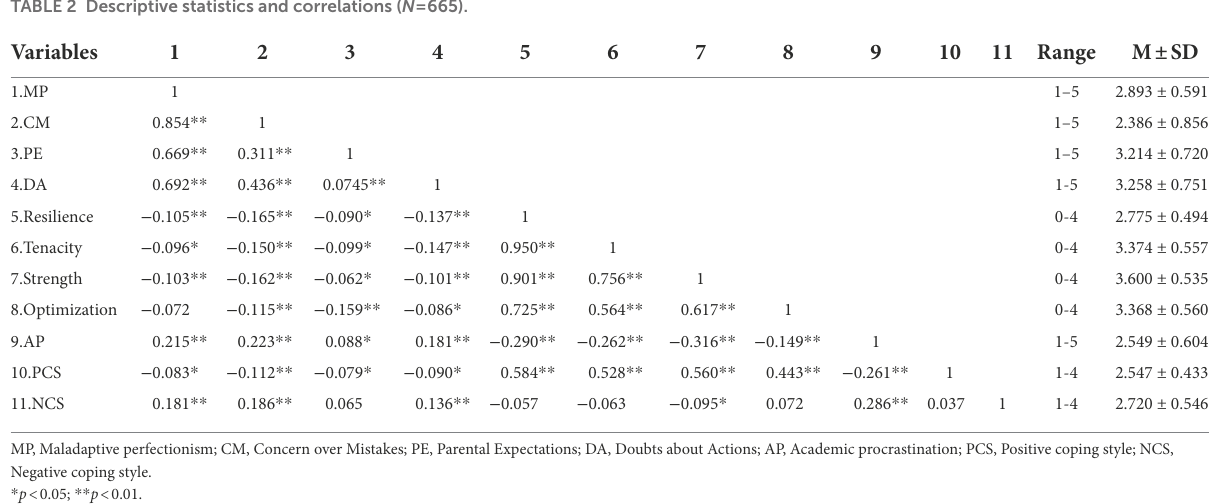
TABLE 2 Descriptive statistics and correlations ( N = 665).